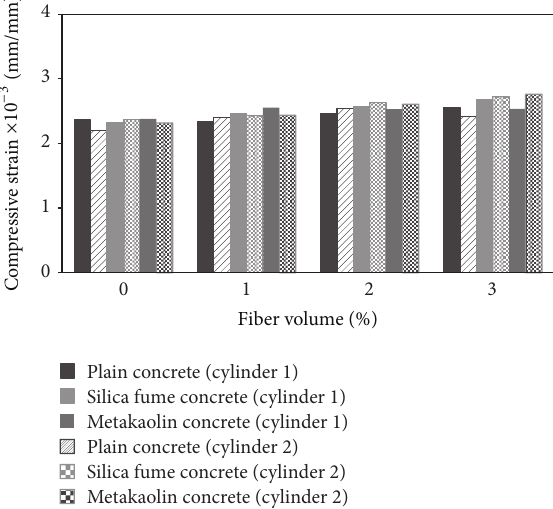
Figure 6: Effect of the Basalt fibers on the compressive strains of HPFRC.